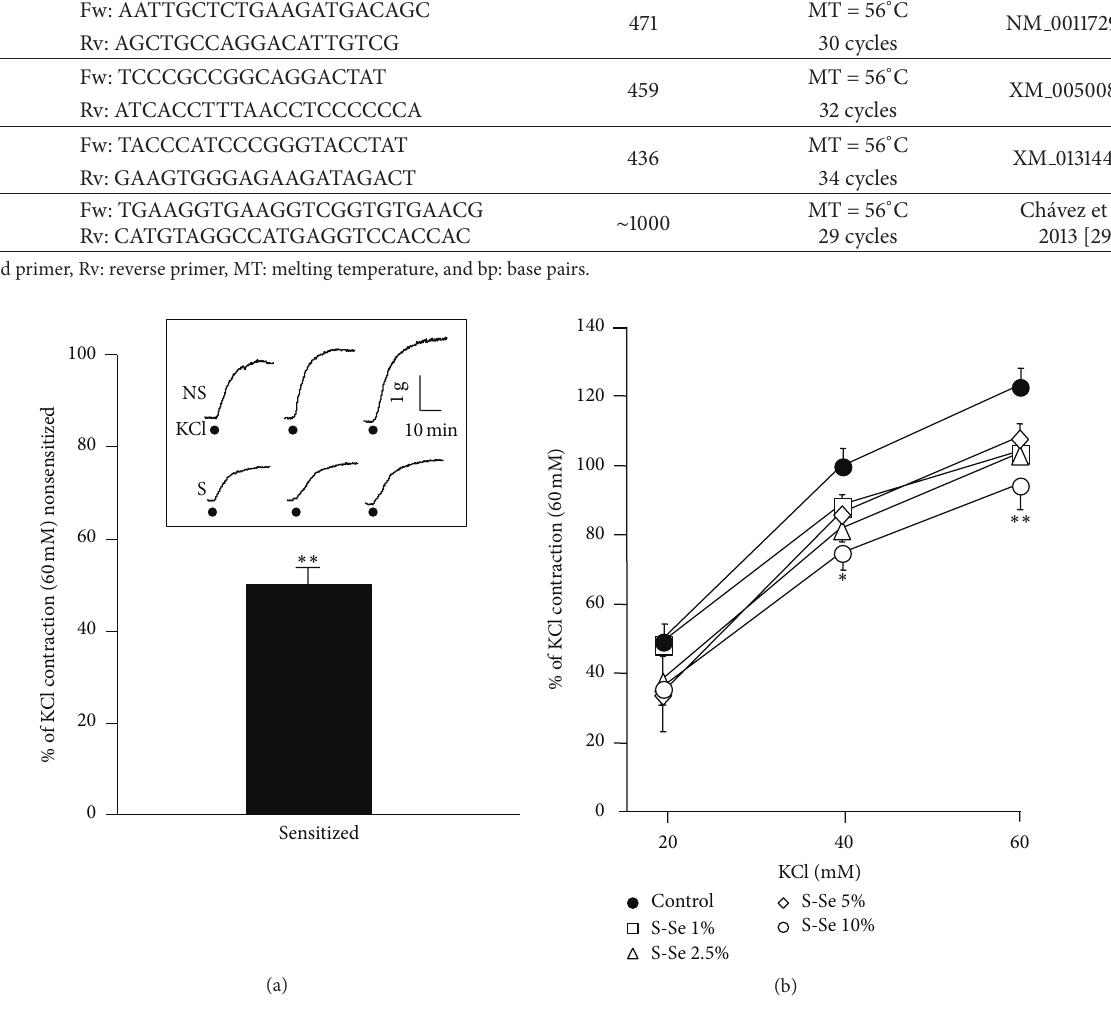
Figure 1: Sensitization diminished KCl-induced contraction in guinea pig tracheas. Responses to 3 consecutive stimulations of 60 mM KCl were higher in tracheal rings from nonsensitized guinea pigs (NS, 𝑛 = 14 ) than in tissues from sensitized (S, 𝑛 = 17 ) animals (inset). (a) The third KCl response from NS tissues was considered as 100%, and statistical difference was found when compared with the S group. (b) Nonsensitized tracheas, incubated with different percentage (V/V) concentrations of sensitized guinea pigs serum (Ser-S, 𝑛 = 5 , each), showed decreased responses to KCl (20–60mM), reaching statistical significance only with the highest Ser-S concentration tested. ∗ 𝑝 < 0.05 , ∗∗ 𝑝 < 0.01 compared with control group. Bars and symbols represent mean ±